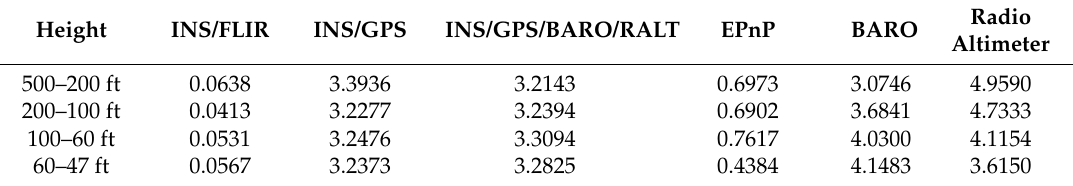
Table 4. RMS Errors of flight height in landing phase, unit (m).